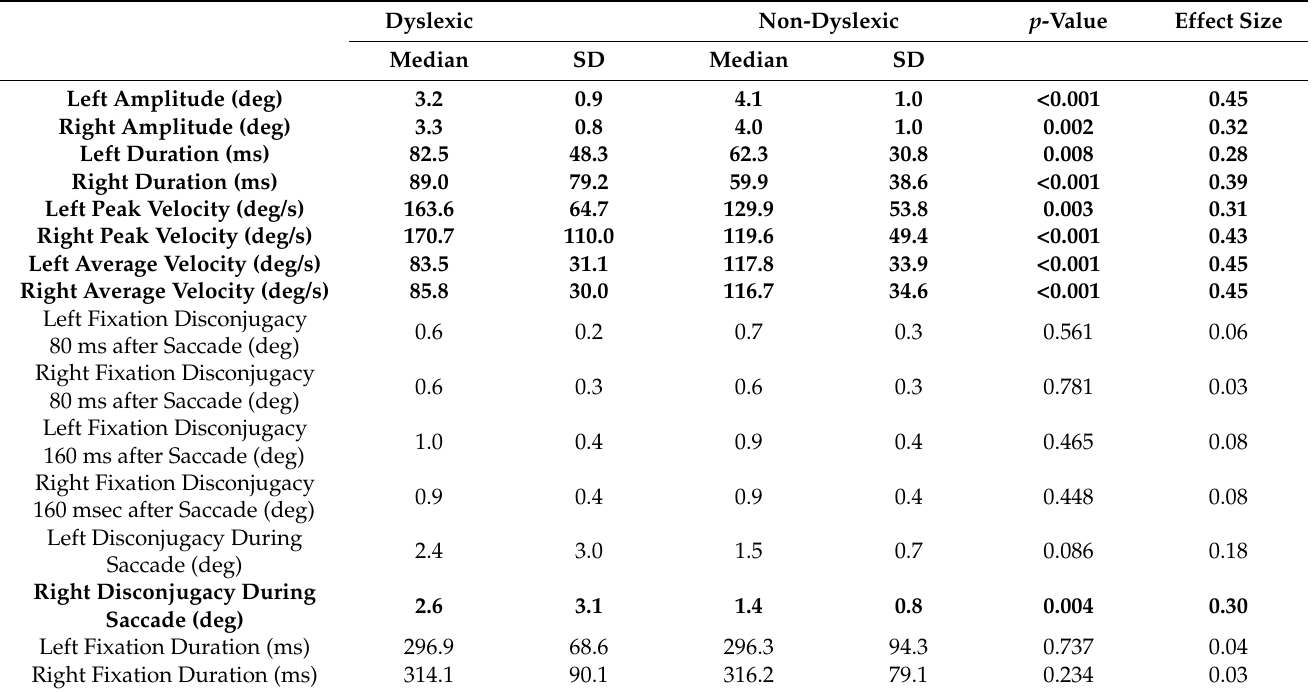
Table 1. Eye movements while viewing Painting 1. Bolded values represent statistically significant